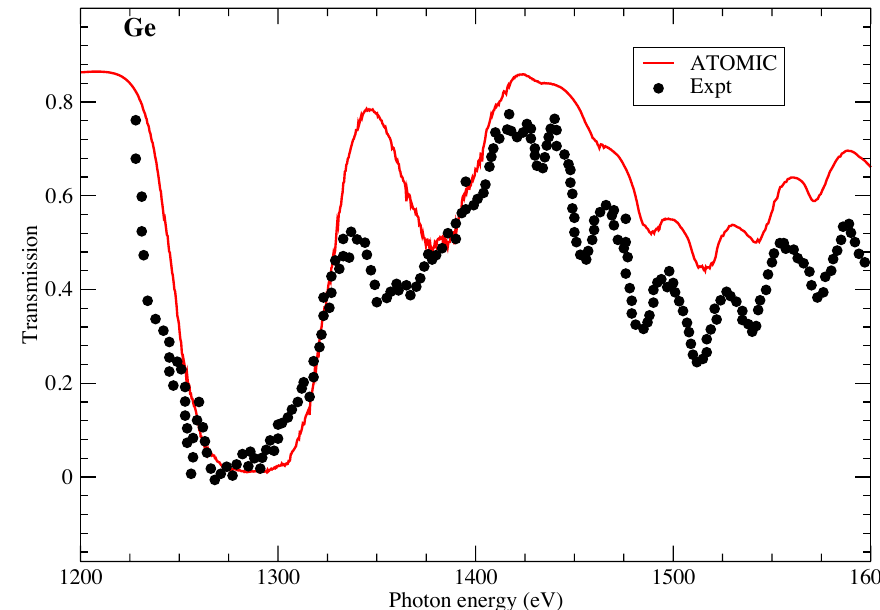
Figure 2. The transmission of Ge as measured by [30]. The experimental data are compared with ATOMIC calculations at a temperature of 76 eV and a mass density of 0.05 g/cm 3 .